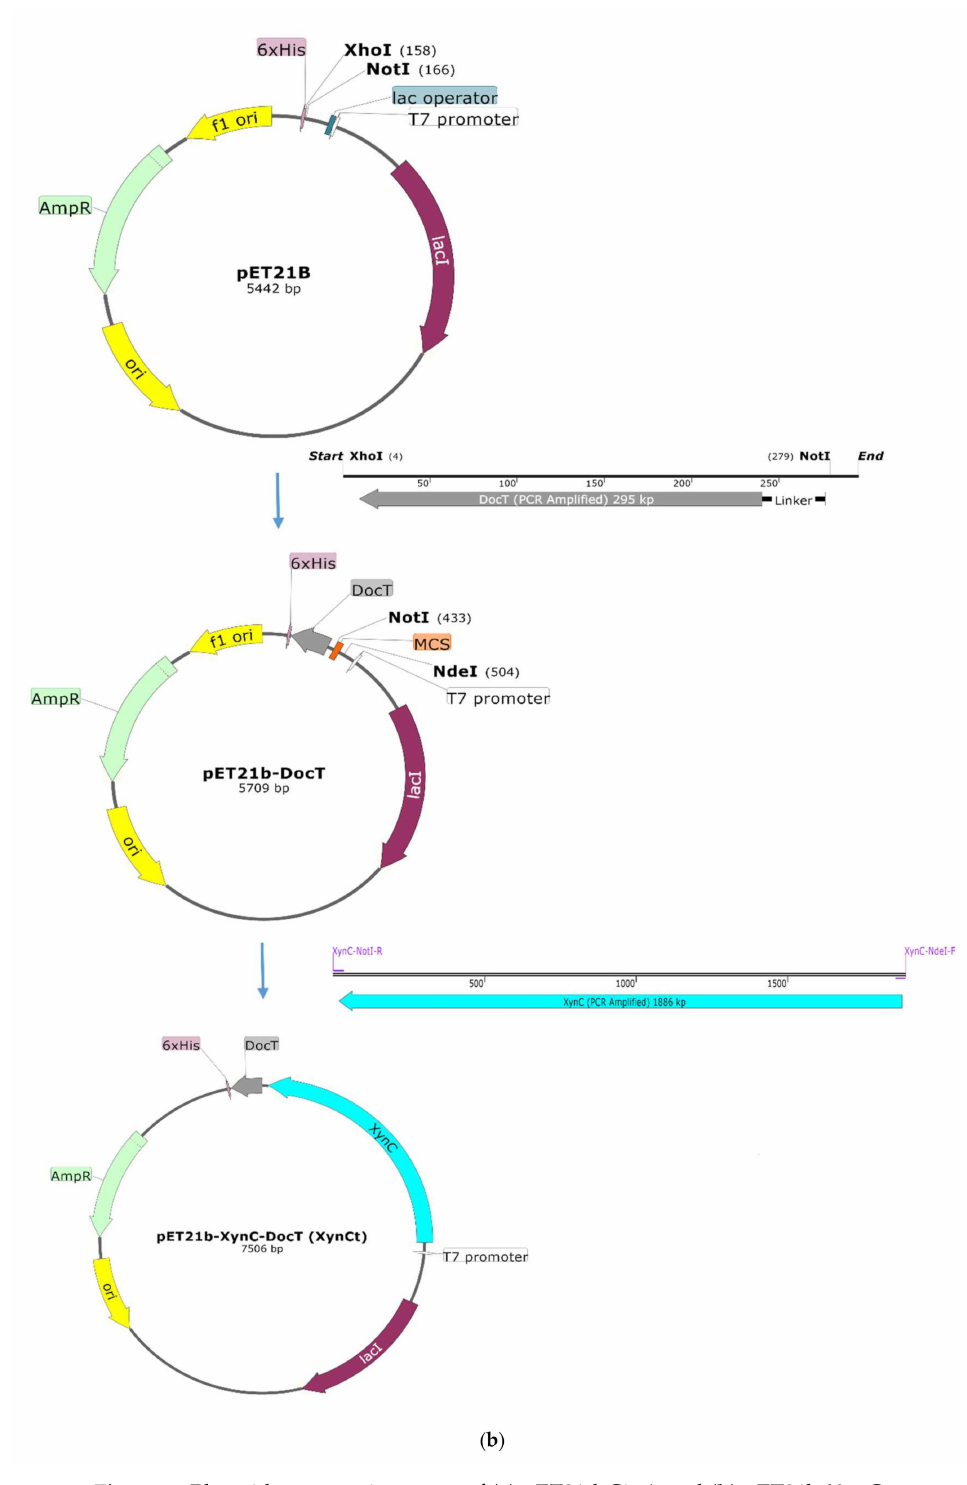
Figure 2. Plasmid construction maps of ( a ) pET21d-CipA and ( b )